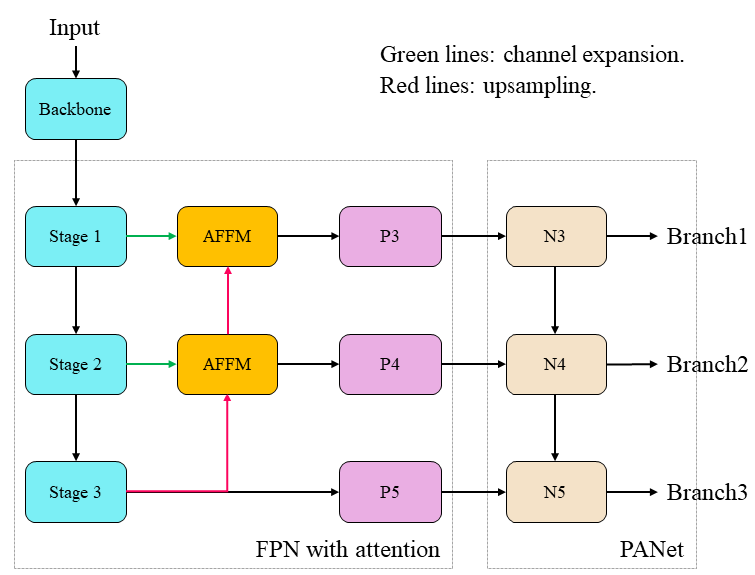
Figure 7. The main structure of FPN-AFFM.